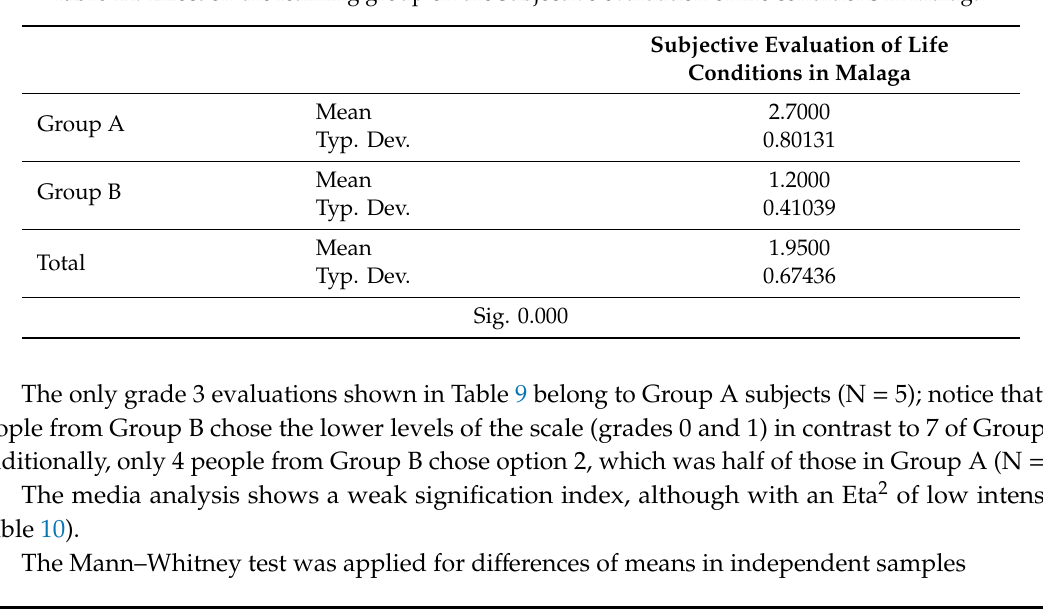
Table 12. E ff ect on the learning group on the subjective evaluation of life conditions in